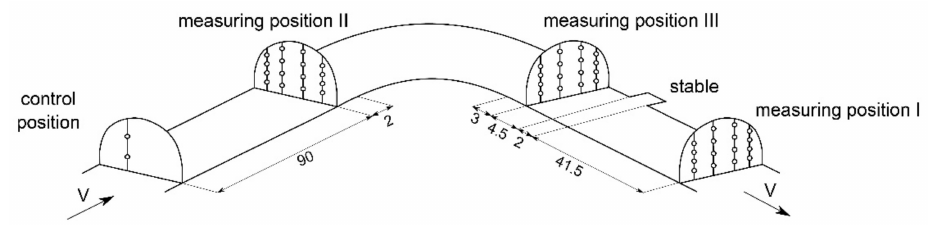
Figure 6. Diagram of arrangement of measuring cross-sections in the mine